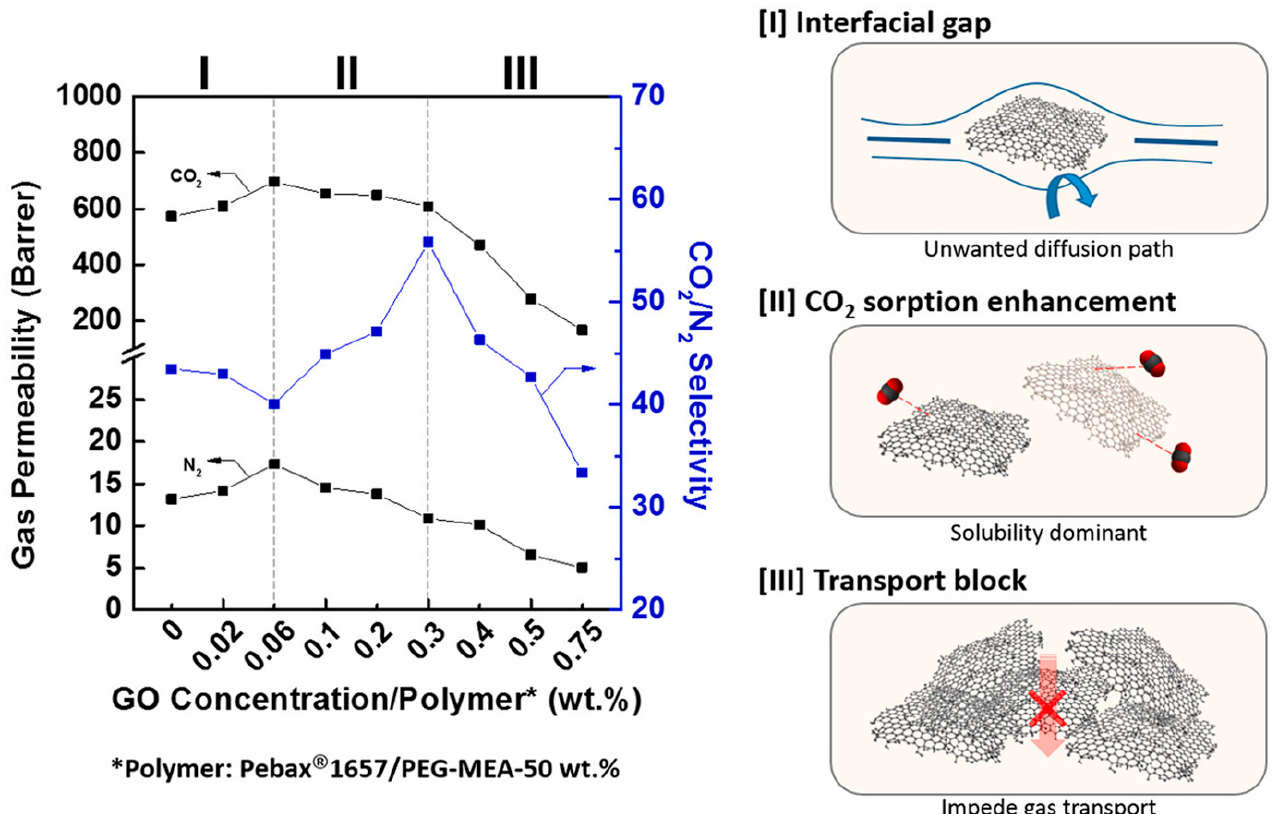
Figure 10. Effect of the GO loading on the permeation properties and schemes evidencing the prevailing transport modes within the MMMs (from ref. [47]).